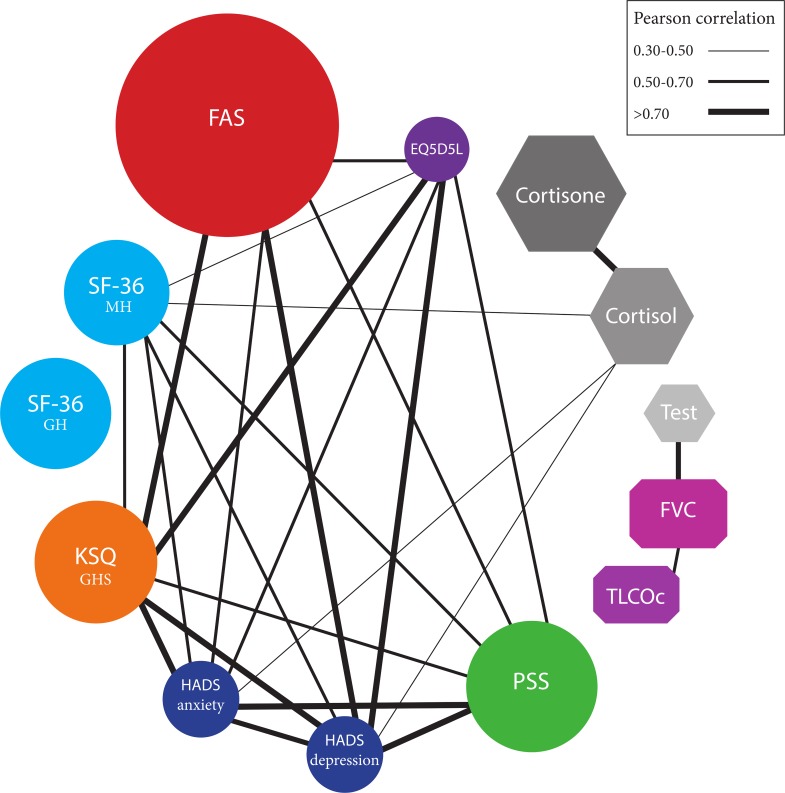
Interaction network showing all significant correlations between hair steroid levels, psychological distress and fatigue scores, and pulmonary function tests in sarcoidosis patients (n = 32).Each node of the network corresponds to a questionnaire score, and its size is proportional to the % of the total score of the questionnaire. Two nodes are linked if they significantly correlate, the wider the string the better the correlation. EQ5D5L; Euroqol-5D 5-level; FAS, Fatigue Assessment Scale; SF-36, Short Form-36; MH, mental health domain; GH, general health domain; KSQ; King's Sarcoidosis Questionnaire; GHS, General Health Status domain; HADS, Hospital Anxiety and Depression Scale; PSS, Perceived Stress Scale; TLCOc, transfer factor for carbon monoxide corrected for hemoglobin; FVC, forced vital capacity; Test, testosterone.